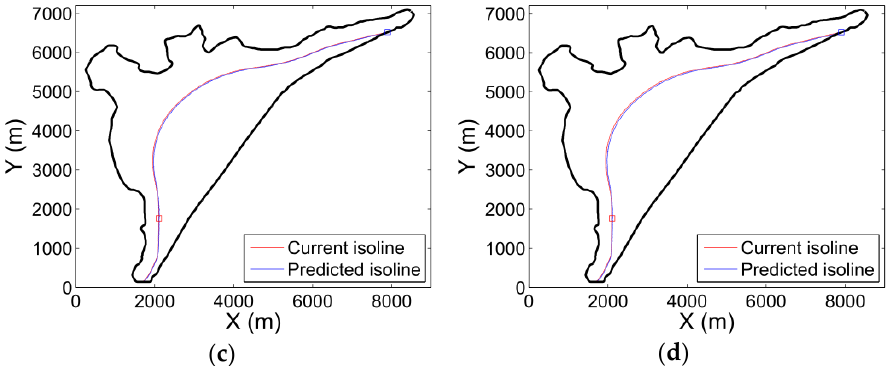
Figure 4. Advancement of the 100 meter level set of the seawater/freshwater interface for different sea level rises: ( a ) 50 cm; ( b ) 100 cm; ( c ) 150 cm; and ( d ) 200 cm.